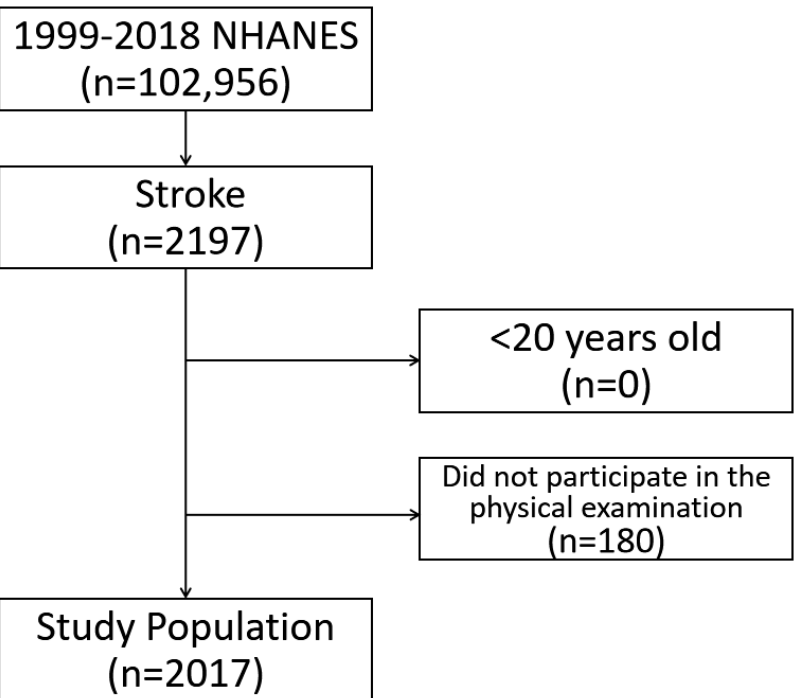
Figure 1. Participant flowchart.